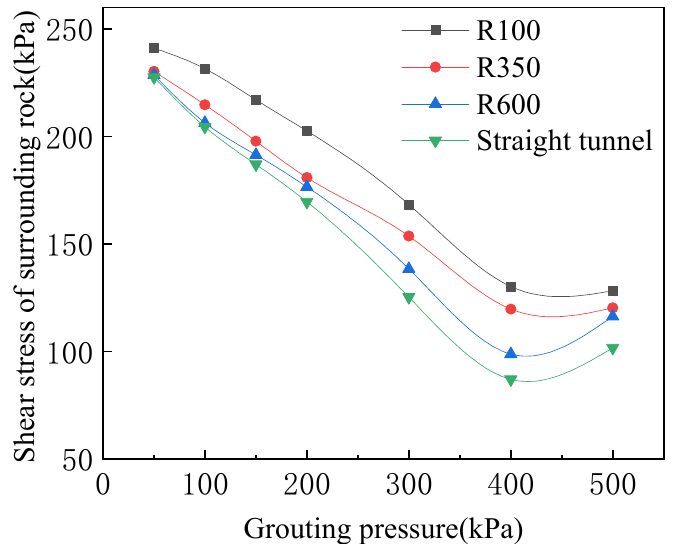
Figure 13. Variation curve of maximum shear stress of surrounding rock with the grouting pressure.